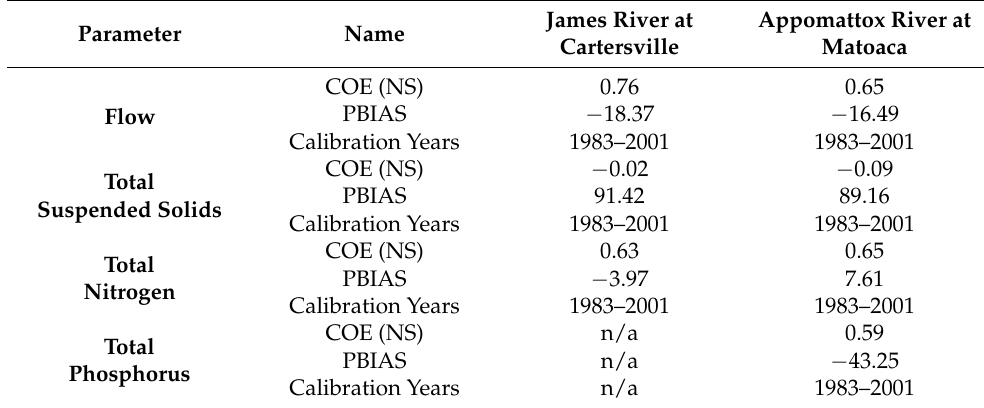
Table 2. Calibration parameters for Nash–Sutcliffe efficiency (COE or NS) and percent bias (PBIAS) for two sites in the James River watershed